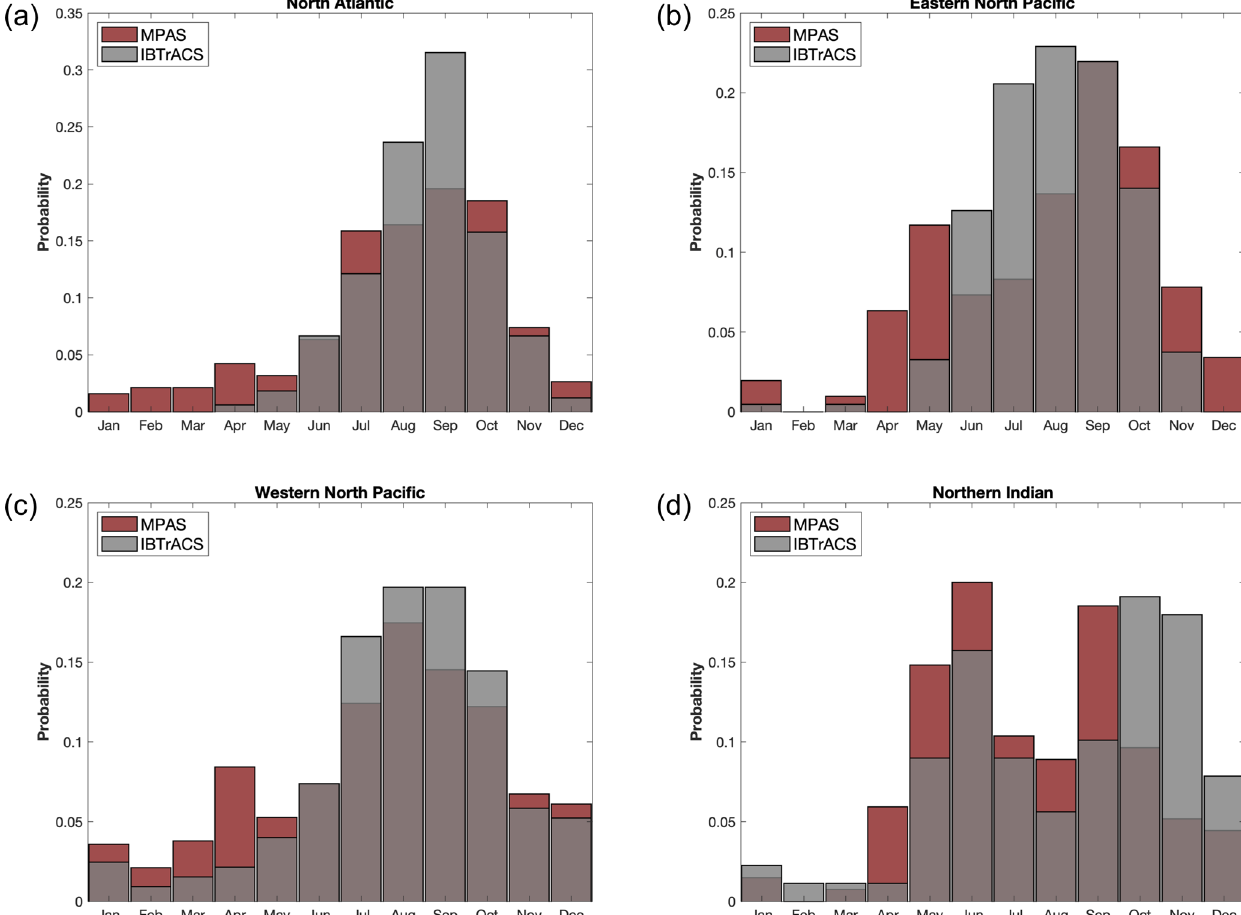
Figure 10. Monthly-average TC frequency over the 10 simulated years for the (a) North Atlantic, (b) eastern North Pacific, (c) western North Pacific, and (d) northern Indian basins. The frequencies for IBTrACS (MPAS-A simulations) are shown in the grey (red)